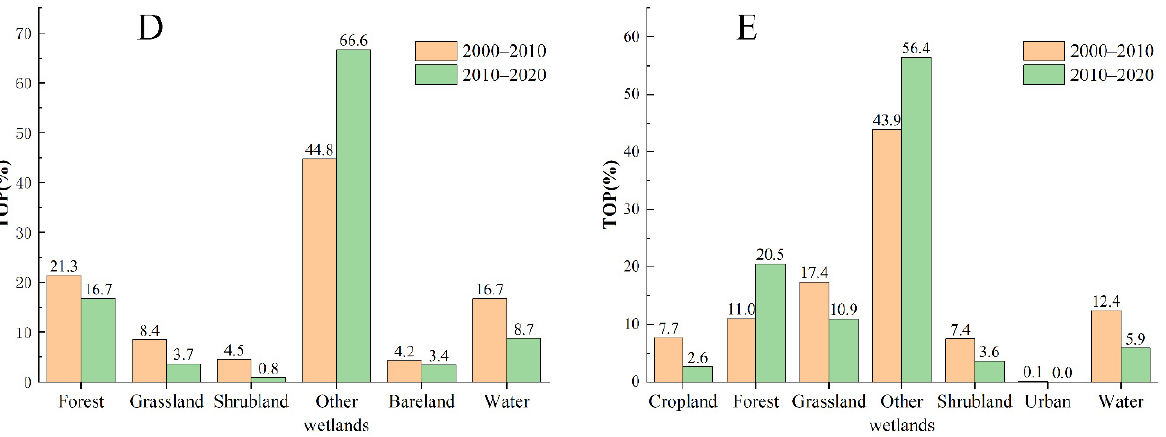
Figure 13. Maps of other land contributing to mangrove transfer out percent (TOP) in Kakadu NP ( D ) and RUMAKI ( E ) from 2000 to 2020 (e.g., a total of 100 ha of mangroves are transferred out, of which 50 ha are other wetlands, the corresponding TOP =